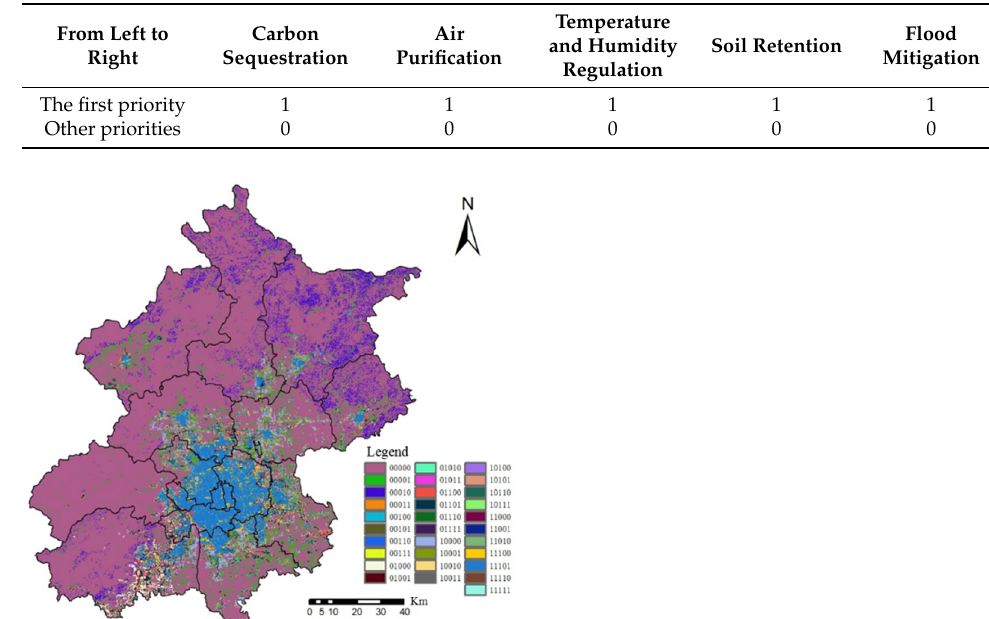
Figure 4. Pixel-scale ECC improvement priority distribution.